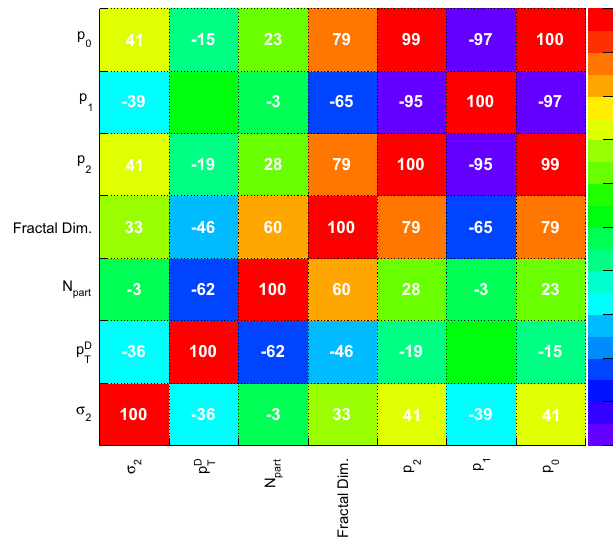
Fig. 4 Left: single variable performance ROC curves. The EFOs, minor axis, and p T D are significantly more discriminating than mul- tiplicity. The EFOs are most discriminating for high signal efficiency ( (cid:2) 70%), below which jet minor axis becomes most discriminating.